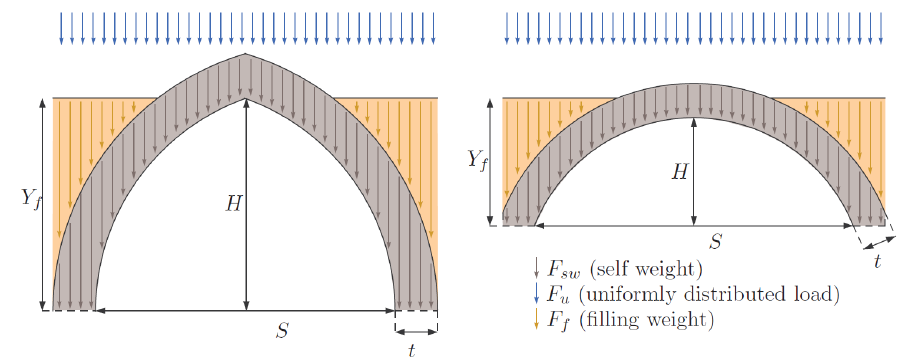
Figure 7: Pointed and lowered